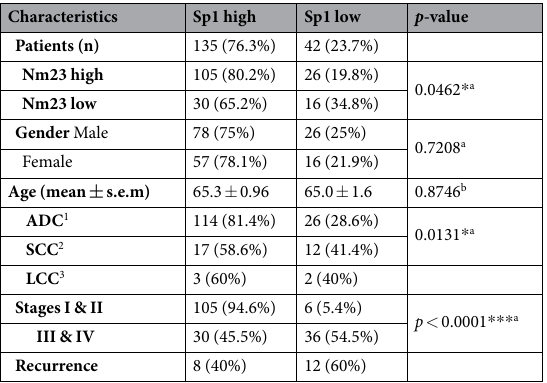
Table 1. Characteristics of lung cancer patients which are involved in determining Sp1 and Nm23 expression by. Abbreviation: 1 adenocarcinoma; 2 squamous cell carcinoma; 3 large cell carcinoma. a Fisher’s extract test,